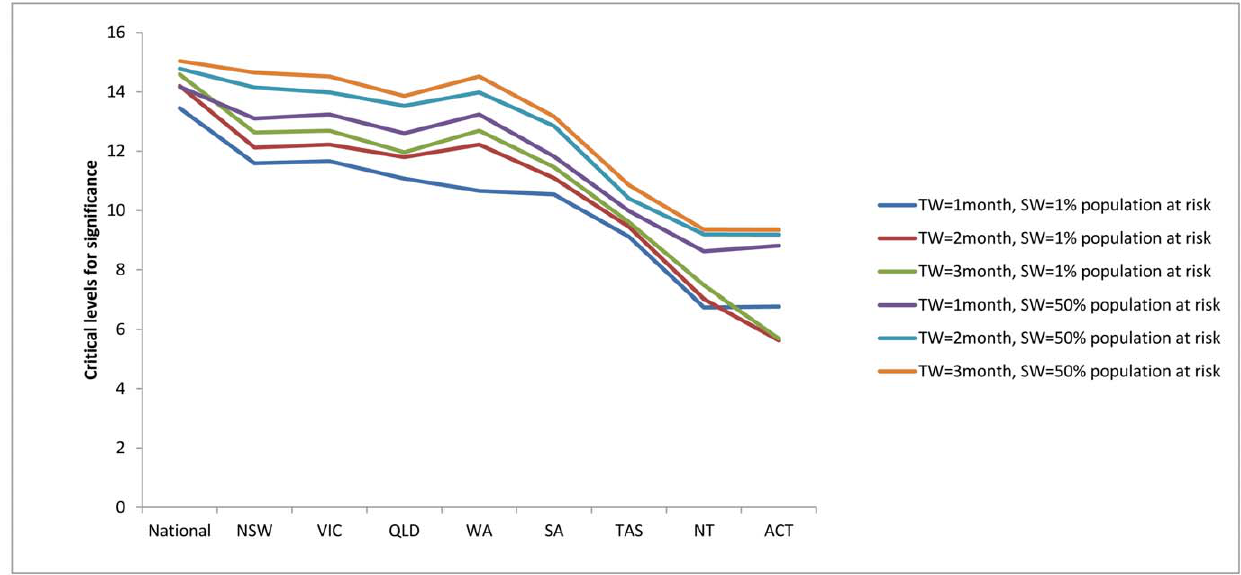
Figure 5. Critical levels for cluster significance (p , 0.05) by national and state cluster detection. Remark: TW=Maximum temporal window size; SW=Maximum spatial window